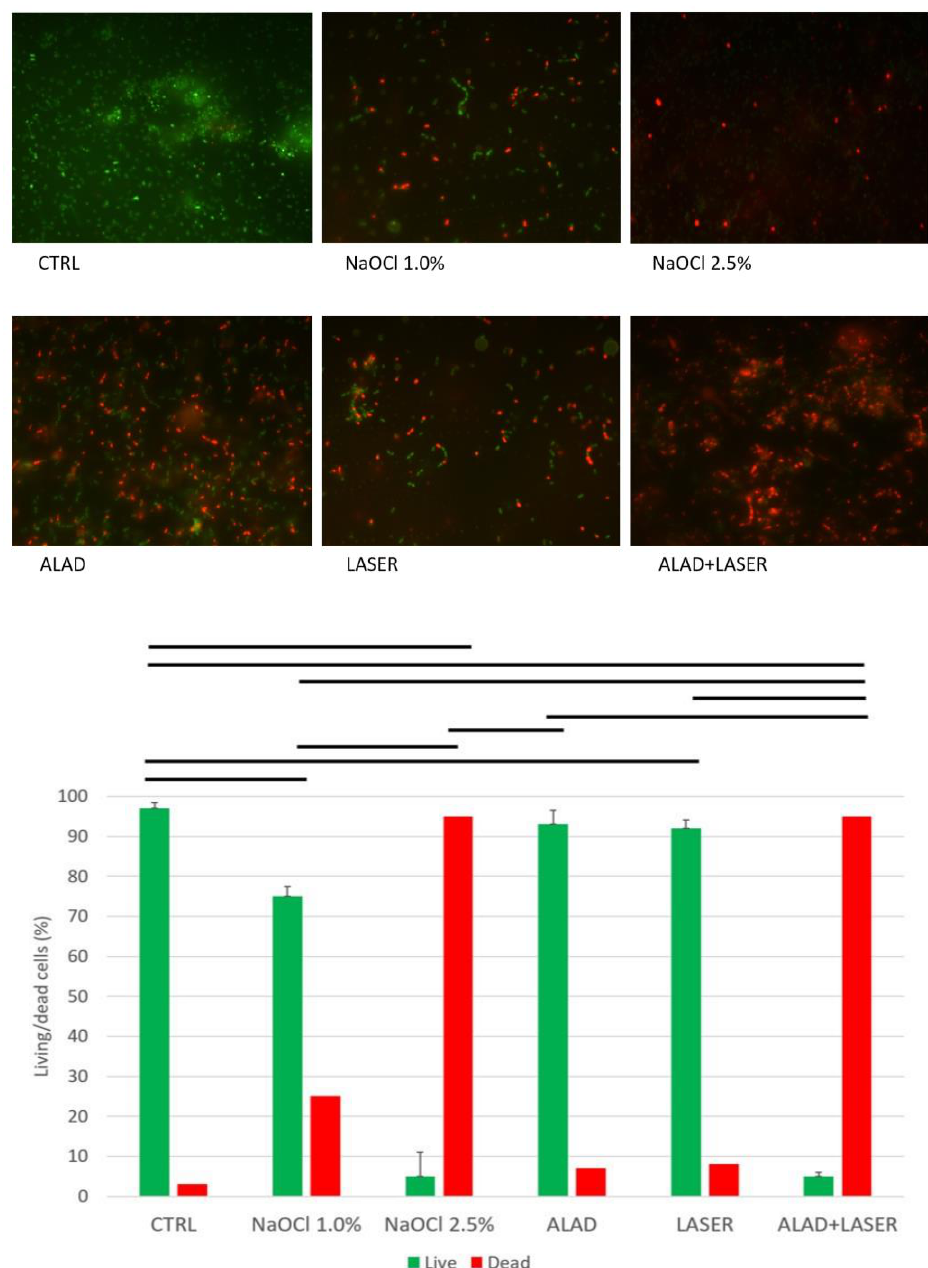
Figure 2. Representative live/dead images of untreated (CTRL) and treated Enterococcus faecalis. The histogram shows the percentages of viable (green bars) and dead (red bars) cells. The horizontal bars show the presence of statistically significant differences ( p < 0.05) between the groups.